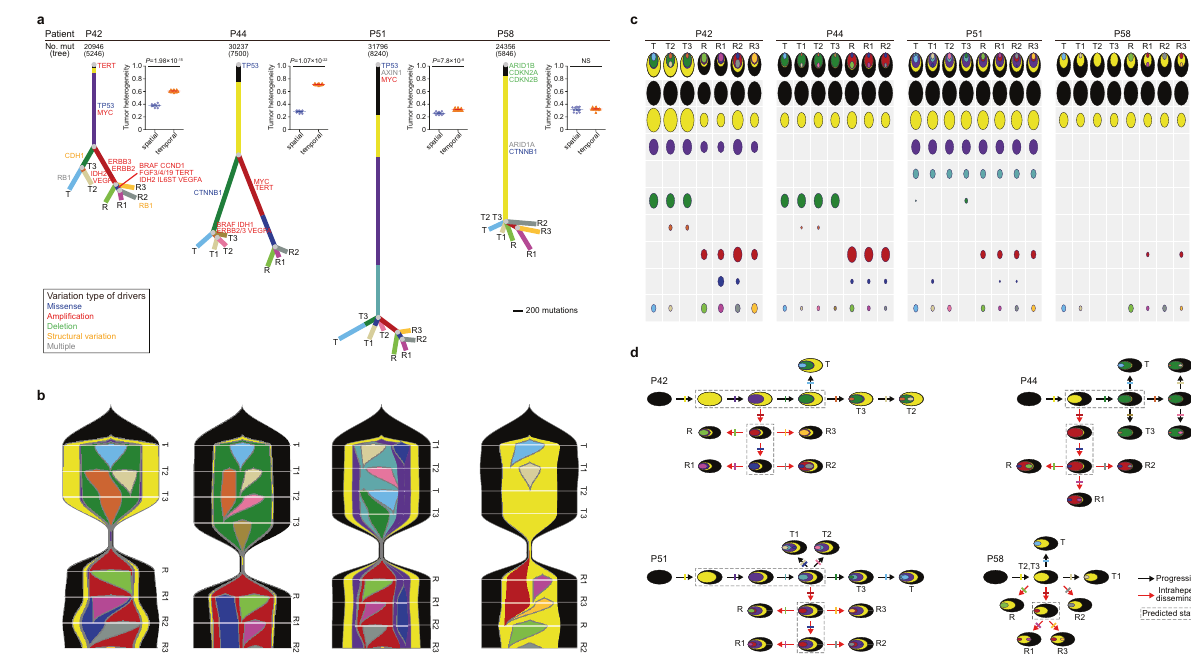
Fig. 6 Spatiotemporal heterogeneity and polyclonal dissemination in four patients with ancestral recurrence revealed by multi-region WGS. a Phylogenetic trees constructed from four patients with ancestral recurrence (total of 30 tumor samples). Trees were derived from somatic mutations (SNVs + indels) in genic region based on subclonal architectures. The numbers of all genome-wide somatic mutations per patient are labeled above the tree (the numbers of somatic mutations in genic region involved in constructing the phylogenetic trees are labeled in brackets). Lengths of lines are proportional to the number of mutations in each cluster. Quanti fi cation of tumor spatial and temporal heterogeneity of each patient is on the right of the corresponding phylogenetic tree. b Fishplot showing the tumor clonal evolution process from primary tumor to early-recurrent tumor. c Oval plots showing the subclonal structure of tumor samples from each patient. The diameter of each oval is proportional to the corresponding CCF value. Subclonal structures are illustrated by the nested ovals. d Clonal evolutionary history. The dashed box shows the predicted historical states during the tumor ancestral recurrence. Black arrows denote clonal evolution during primary tumor progression. Red arrows denote clonal evolution from the primary tumor to recurrent tumor. Arrows are labeled the acquisition of new subclones with orthogonal lines. Each colored line corresponds to a